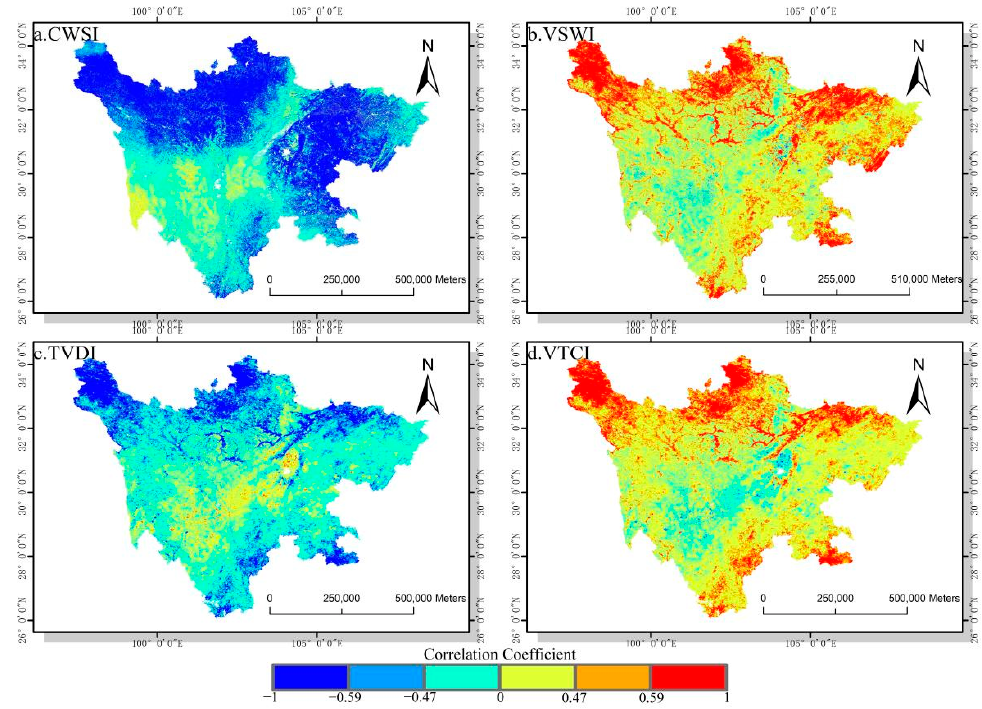
Figure 3. Correlation coefficient between remote-sensing drought Indices and sc-PDSI in 2001–2020. Among them, only the correlation between CWSI and sc-PDSI passes the significance test ( p < 0.05) in most regions, which indicates that CWSI has a better fit to the inter-annual variation in soil drought in the study